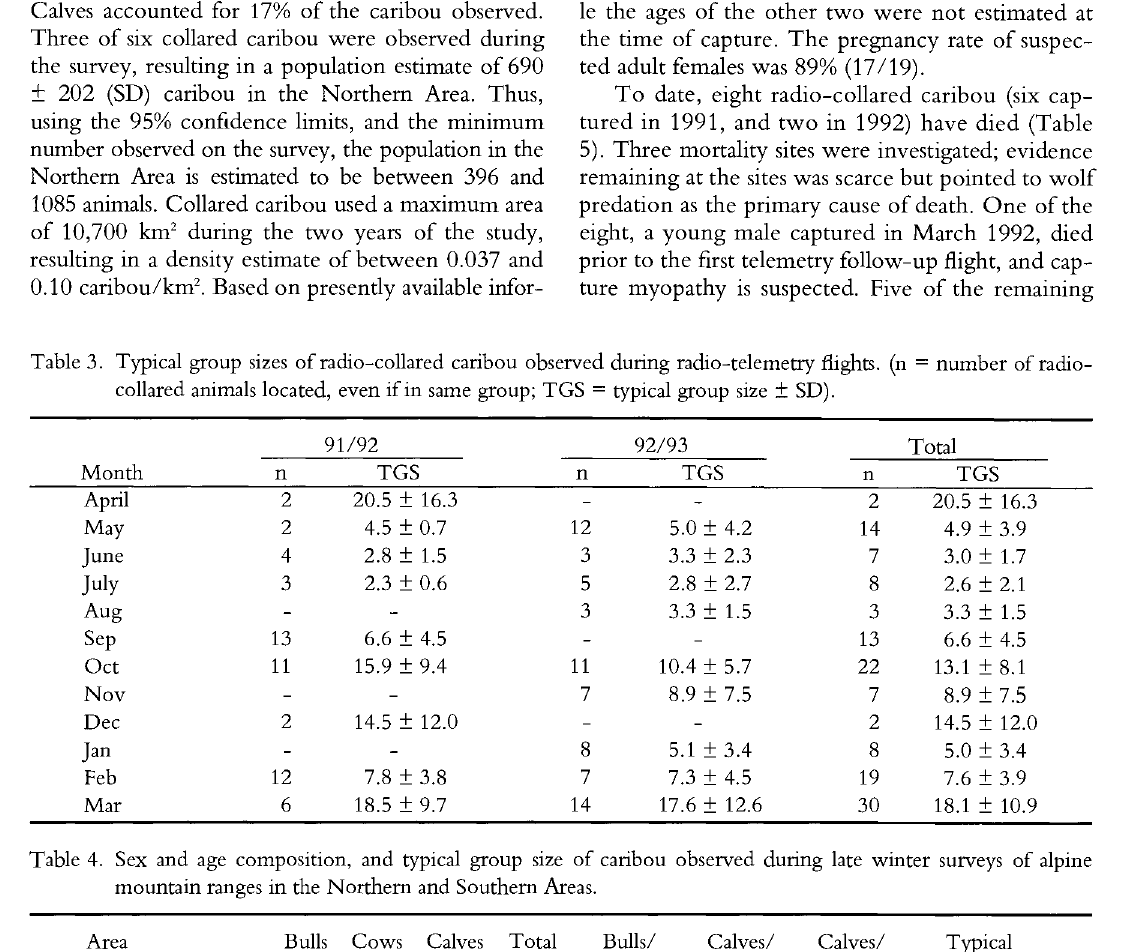
Table 3. Typical group sizes of radio-collared caribou observed during radio-telemetry nights, (n = number of radio- collared animals located, even if in same group; TGS = typical group size + SD).